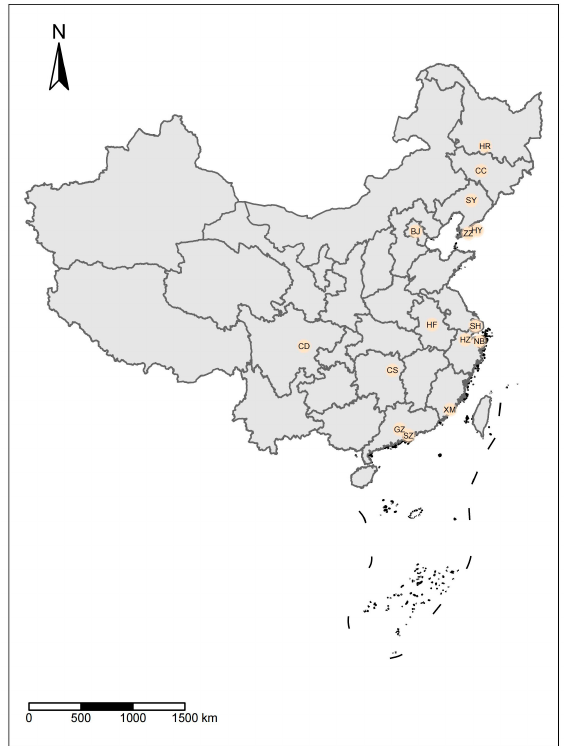
Figure 1. The location of price data collection. Farm-gate price including Zhangzidao (ZZ), and Haiyangdao (HY); wholesale price including Beijing (BJ), Guangzhou (GZ), Shenzhen (SZ), Changsha (CS), Harbin (HR), Changchun (CC), Shenyang (SY), Shanghai (SH), Hangzhou (HZ), Chengdu (CD), Hefei (HF), Ningbo (NB), and Xiamen (XM). In this paper, the farm-gate price refers to the price of P. yessoensis produced in Zhangzidao (ZZ) and Haiyangdao (HY); it is divided into extra large (EL), large (L), medium (M), small (S), and extra small (ES) by specification (Table 1). The wholesale price refers to the market price in Beijing (BJ), Guangzhou (GZ), Shenzhen (SZ), Changsha (CS), Harbin (HR), Changchun (CC), Shenyang (SY), Shanghai (SH), Hangzhou (HZ), Chengdu (CD), Hefei (HF), Ningbo (NB), and Xiamen (XM) (Table 2). The unit is Chinese Yuan per the boxplot of price series with minimum, lower quartile (25th percentile), median (50th percentile), upper quartile (75th percentile), and maximum. Table 1. Specification description in farm-gate